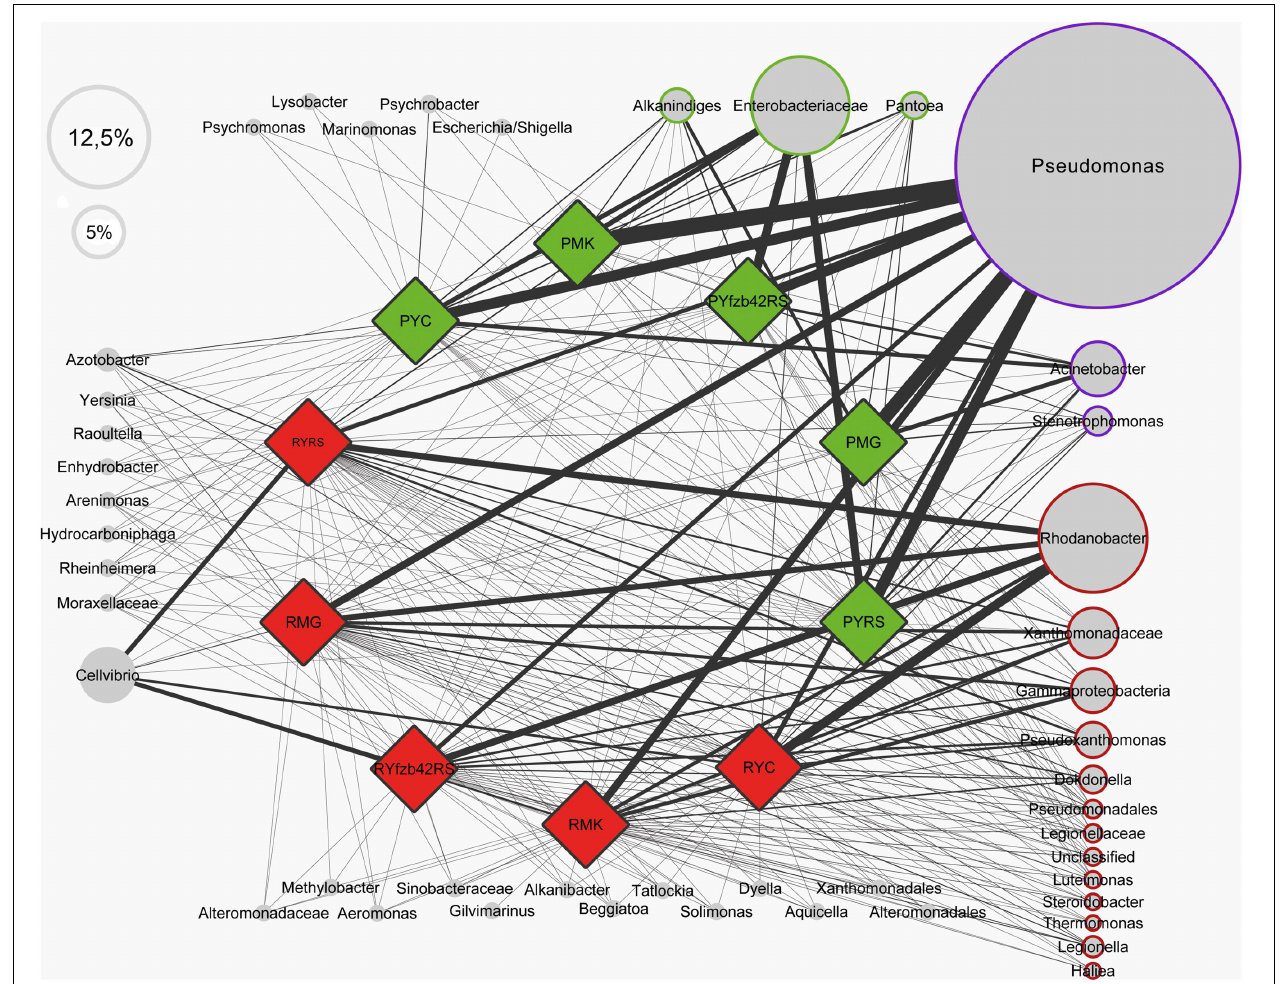
FIGURE 2 | Profile clustering network visualizing the investigated groups of lettuce (var. Tizian) and conjoined taxa. Red diamonds indicate samples derived from the roots and green diamonds from the lettuce foliage, respectively. Nodes represent taxa derived from the RDP classifier and the node sizes correspond to the mean relative abundance of all samples. The abundance of a certain taxa correlated to a particular investigated group is visualized trough the line width of the corresponding